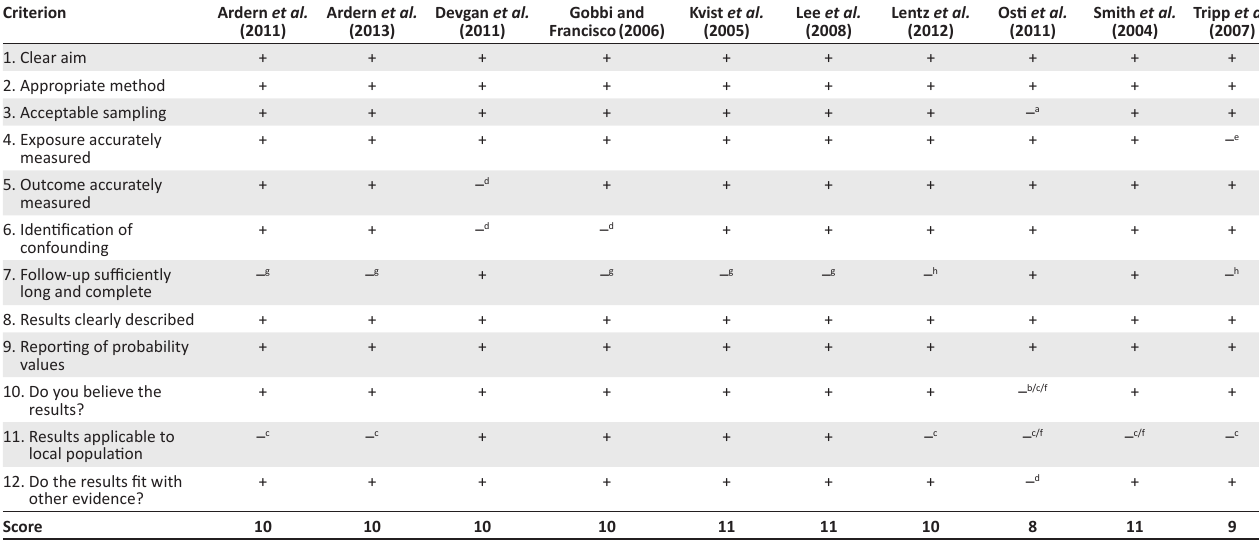
TABLE 1: Findings of critical appraisal of methodological quality. Criterion